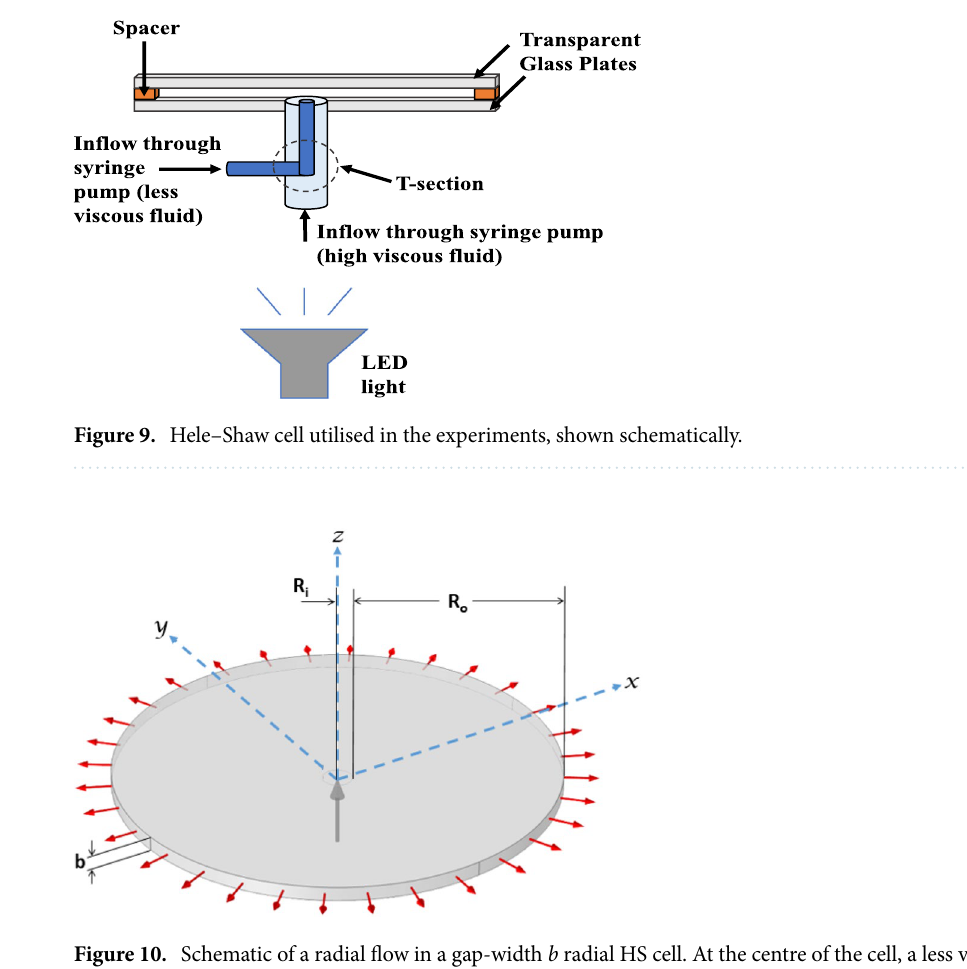
Figure 10. Schematic of a radial flow in a gap-width b radial HS cell. At the centre of the cell, a less viscous fluid is injected with a constant flow velocity